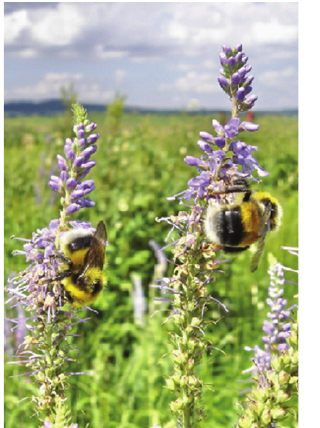
Figure 10: Newly emerged B. lucorum males feeding on Veronica longifolia inflorescences.